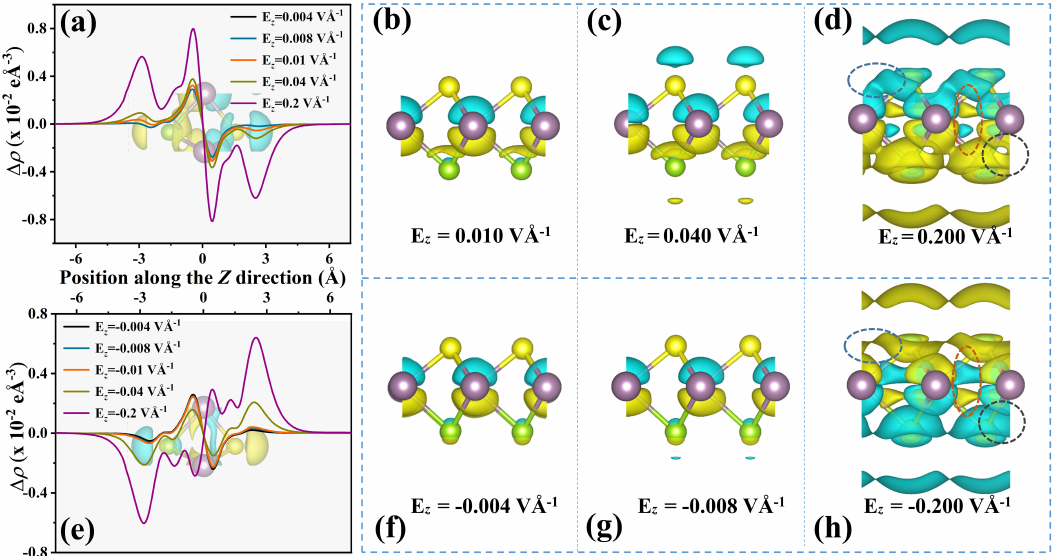
Fig. 4 The difference in charge density induced by the representative positive a and negative e electric fi elds. The detailed analysis is presented based on the representative electric fi elds of 0.010 b , 0.040 c , and 0.200 VÅ − 1 d , as well as − 0.004 f , − 0.008 g , and − 0.200 VÅ − 1 h ( Δ ρ = ρ (E z ) – ρ (E z = 0)) (yellow: positive accumulation of charge, blue: negative depletion of charge). The isosurface is 10 − 5 for the contour plot.